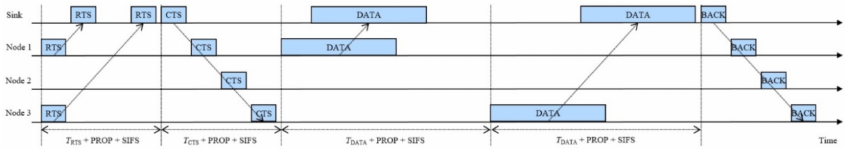
Figure 2. An example of the proposed underwater BACK